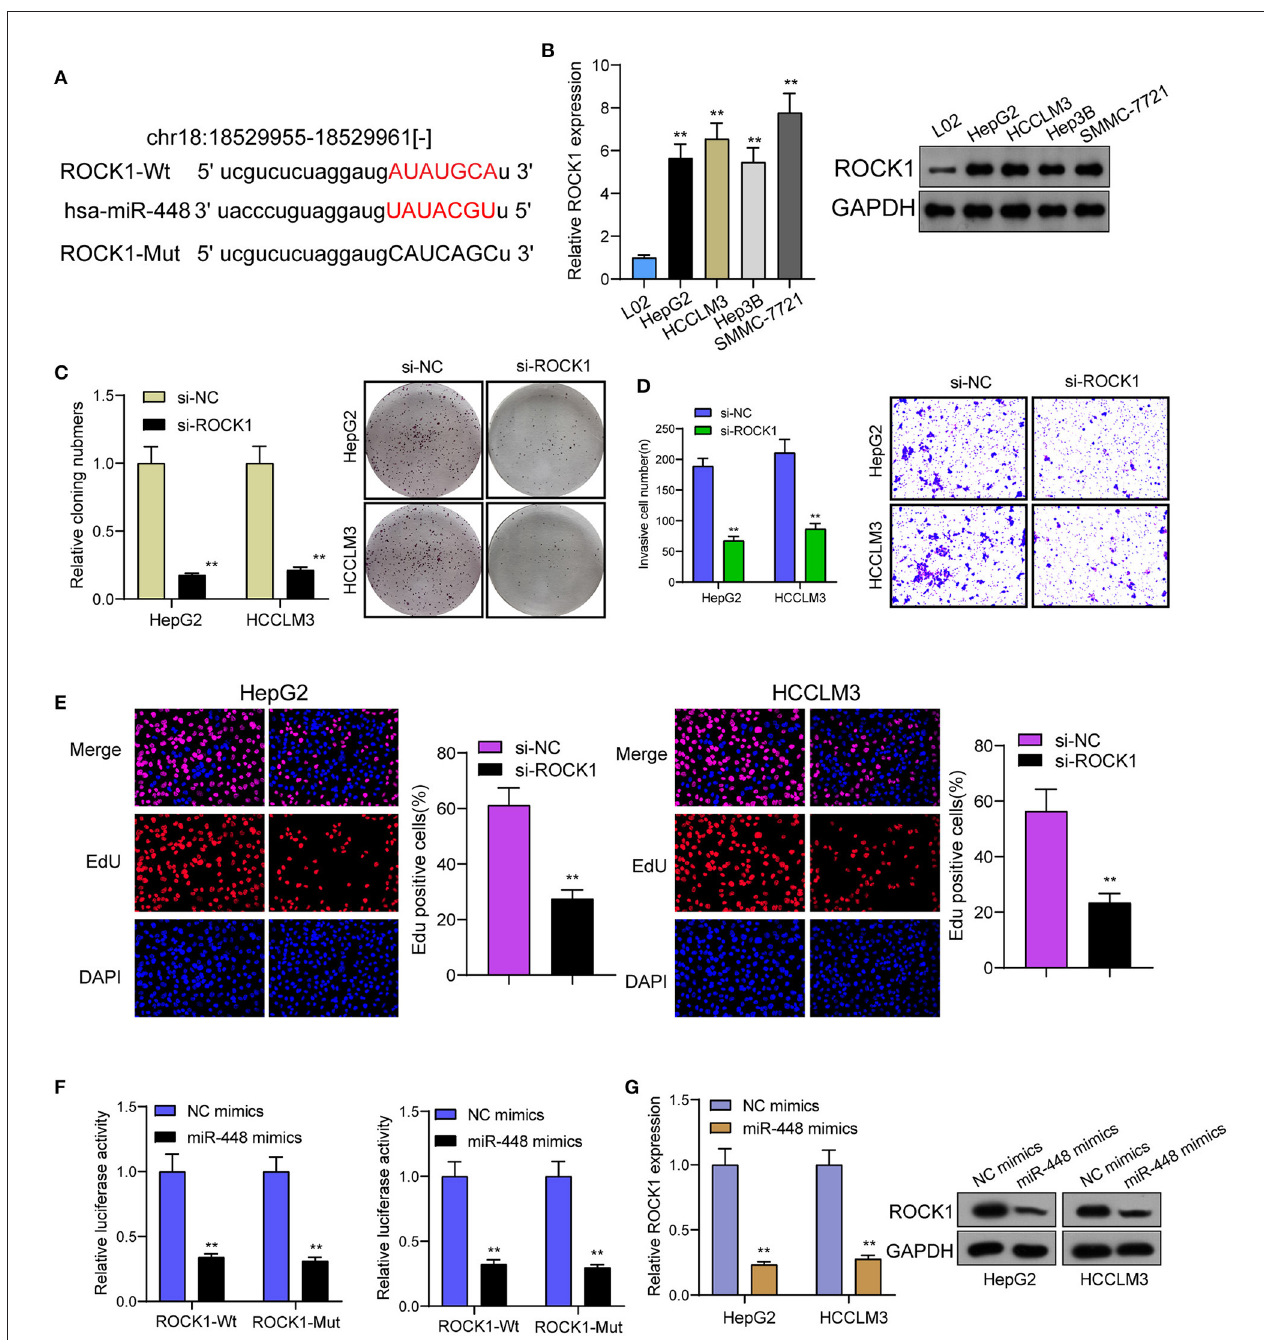
FIGURE 5 | miR-448 regulated ROCK1 expression in HCC cells. (A) The predicted miR-448 target site in the 3 ′ UTRof ROCK1 mRNA and its mutated version. (B) ROCK1 levels in different HCC cell lines were measured by RT-PCR and western blot. (C) The cell proliferation in response to ROCK1 knockdown was examined using colony formation analysis. (D) Transwell assays were conducted to measure cell invasion. (E) EdU were performed to detect cell proliferation after knockdown of ROCK1. (F) miR-448 significantly suppressed the luciferase activity that carried wild-type ROCK1 but not the mutant ROCK1. (G) Overexpression of miR-448 suppressed the expression of ROCK1 in HepG2 and HCCLM3 cells. ** P < 0.01.